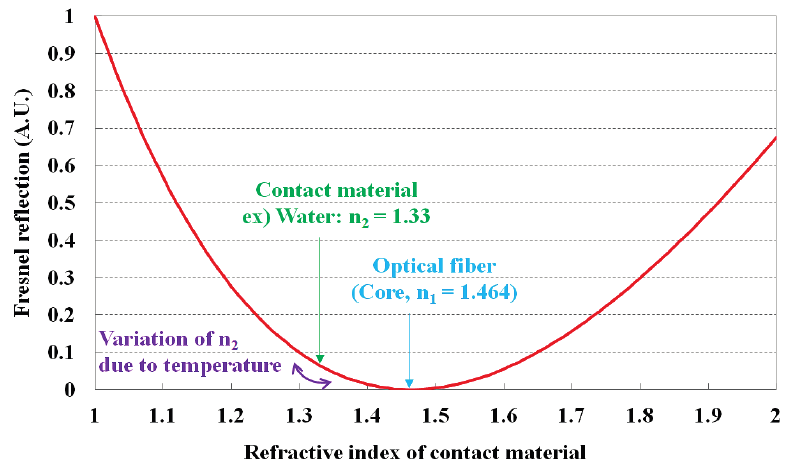
Figure 1. Relationship between the refractive index of the contact material and the Fresnel reflection when the core refractive index of optical fiber is